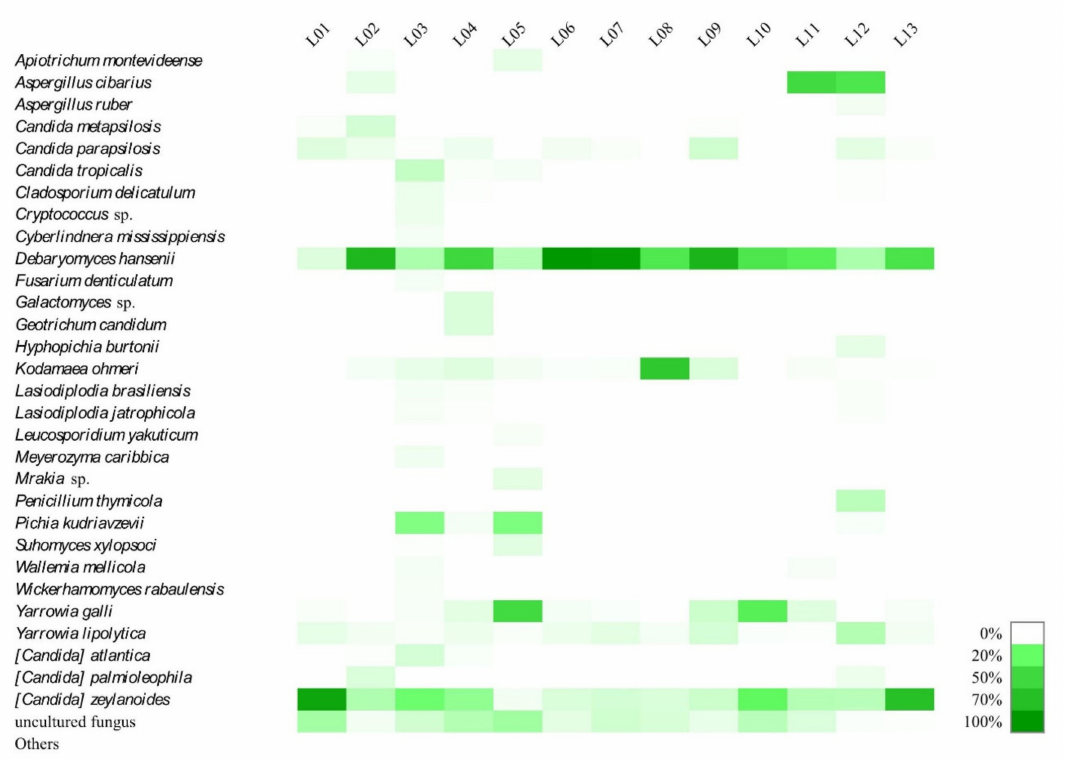
Figure 2. Relative abundance (%) of fungal species in artisanal Colonial salami-type dry-fermented sausages. Species with a very small number of reads (relative abundance < 1%) were classified into in the category